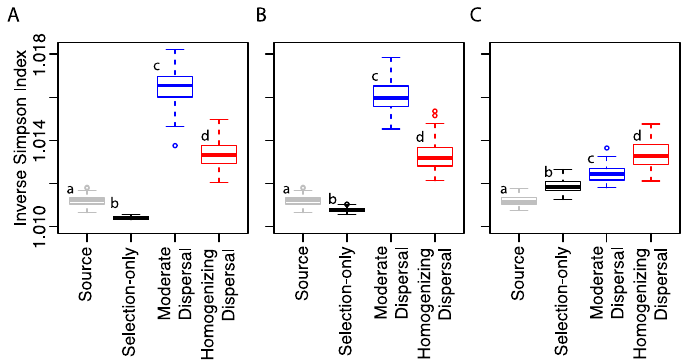
Figure 2. Alpha diversity (inverse Simpson Index) of communities assembled under wide (( A ), niche breadth = 0.175), moderate (( B ), niche breadth = 0.086842105), and narrow (( C ), niche breadth = 0.0075), niches in the mid-point environment (0.476315789). Upper and lower hinges of the box plots represent the 75th and 25th percentiles and whiskers represent 1.5 times the 75th and 25th percentiles, respectively. Colors coincide with labels on the x -axis.